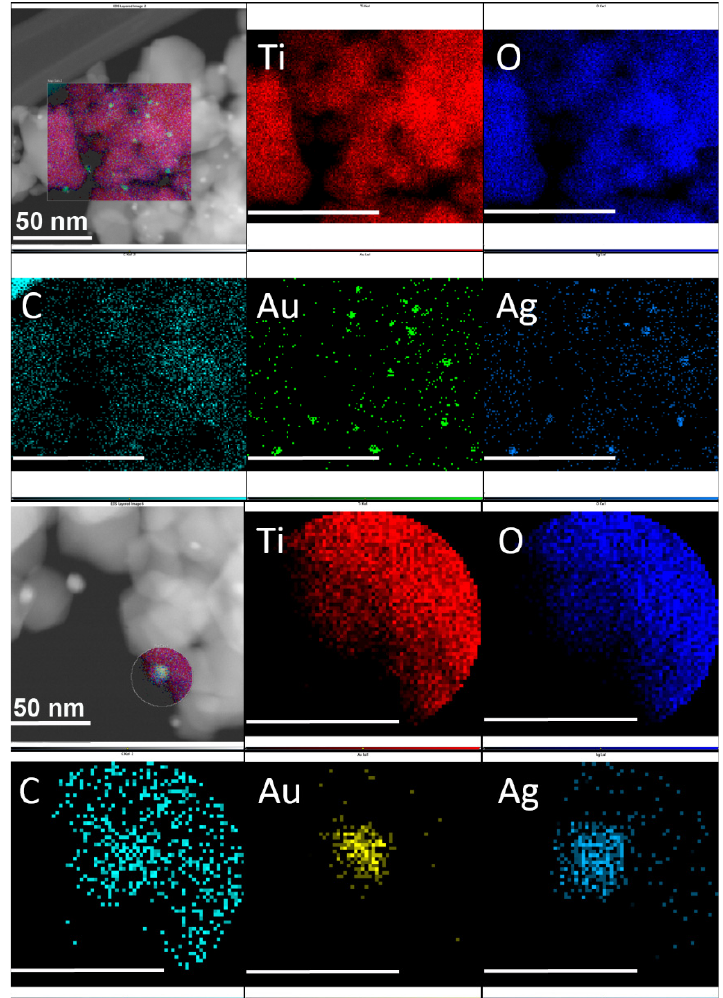
Figure 3. Lower-magnification ( up ) and detailed ( bottom ) HAADF-STEM images of AuAg-NPC- TiO 2 nanohybrid 2 . EDS elemental mapping images for elements Ti, O, C, Au and Ag: larger images display all elements mapping together, while the rest of the images display the individual Ti, O, C, Au and Ag elemental maps, respectively (bar corresponds to 50 nm for the lower magnification images and 25 nm for the detailed images).